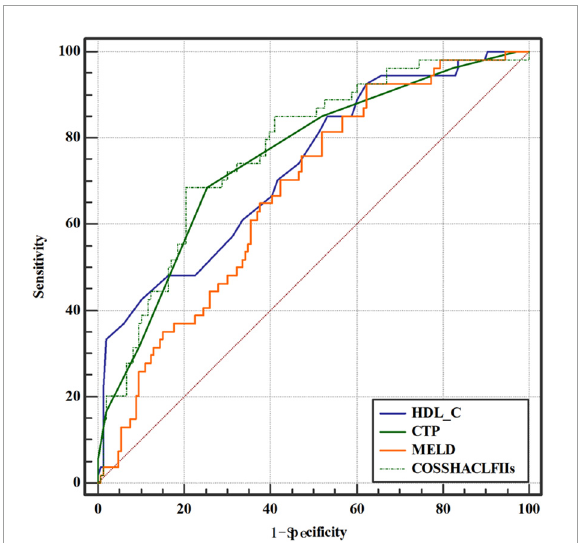
FIGURE3 Area under the receiver operating characteristic (ROC) curve comparison of high-density lipoprotein cholesterol (HDL-C) and the child-turcotte-pugh (CTP), model for end-stage liver disease (MELD), and Chinese Group on the Study of Severe Hepatitis B-ACLF II (COSSH-ACLF II) scores for the prediction of poor outcomes in hepatitis B virus-related acute-on-chronic liver failure (HBV-ACLF)